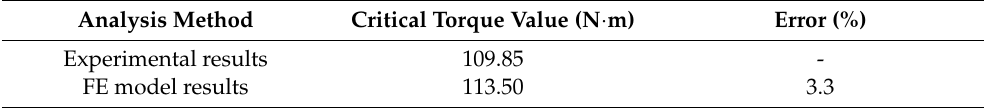
Table 5. Critical torque values of the bellows in different analysis models.